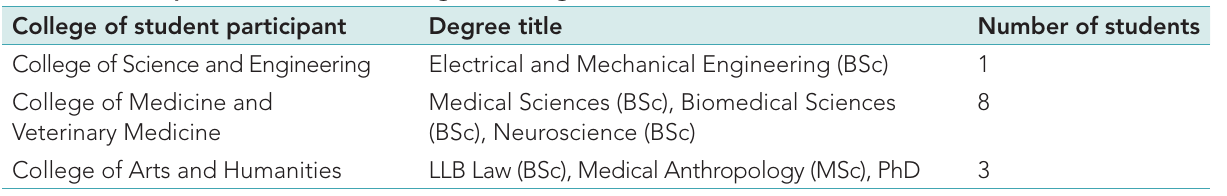
Table 2: Descriptions of student college and degree title (Source: Authors, 2022)